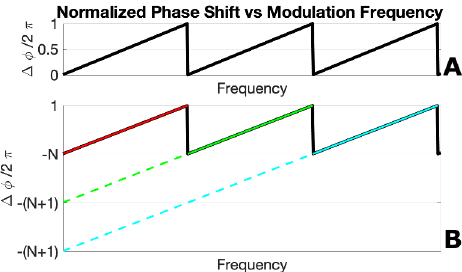
Figure 2. Normalized phase shift for a fixed distance. The col- ored lines in B are a fit of eq. 6 in the positive slope region of the normalized phase shift.